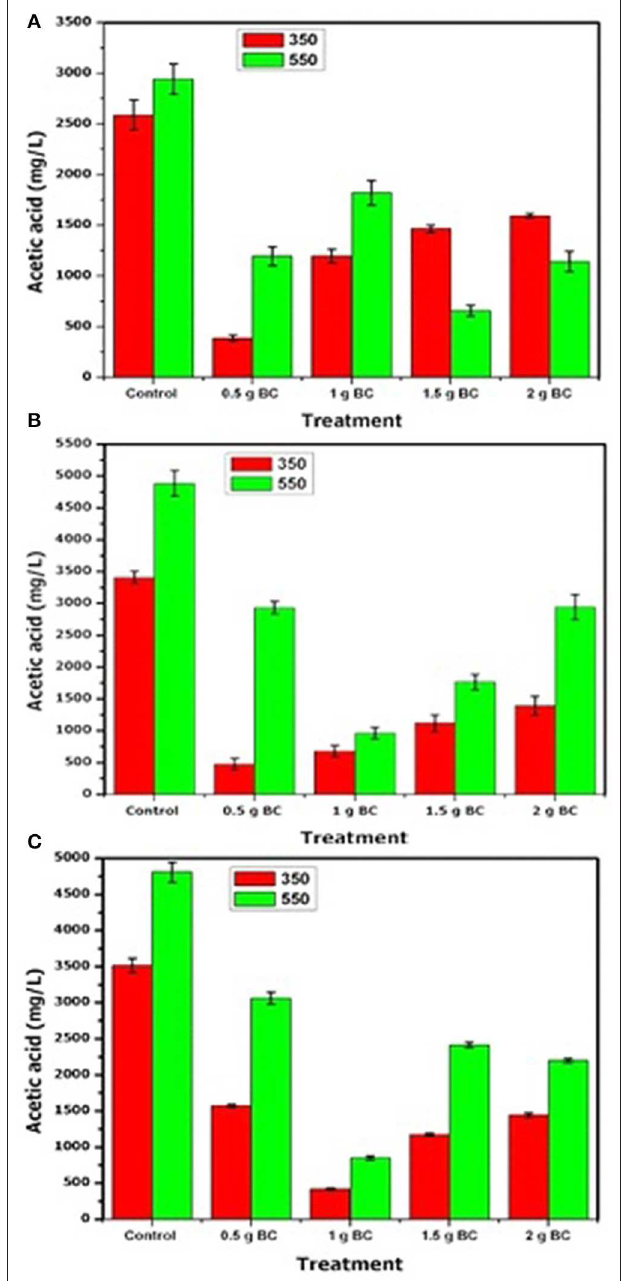
FIGURE 3 | Volatile fatty acid (acetic acid) concentration in anaerobic digestion for ISR 2 (A) , ISR 1.5 (B) , ISR 1 (C) and the addition of different amounts of sludge biochar obtained at 350 and 550 ◦ C. Data are means of triplicates and error bars show standard deviations.